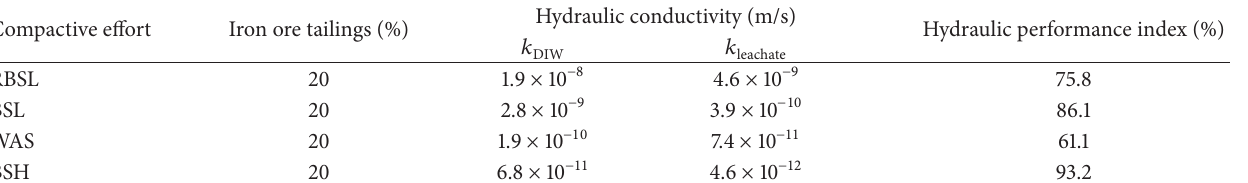
Table 6: Hydraulic performance of the soil at 20% iron ore tailings content.